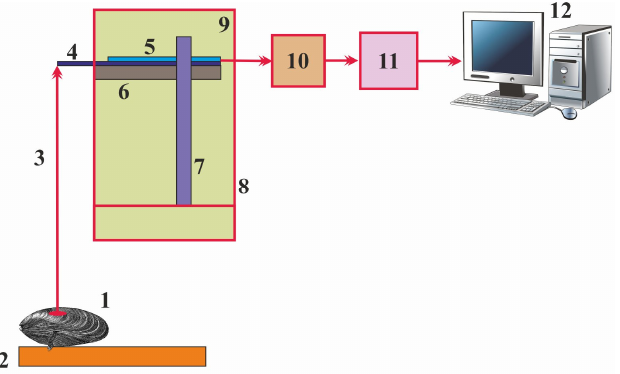
Figure 1. Scheme of the gaping activity registration system developed by the Murmansk Marine Biological Institute [48]. 1—mussel, 2—platform, 3—flexible or rigid link, 4—thin flexible